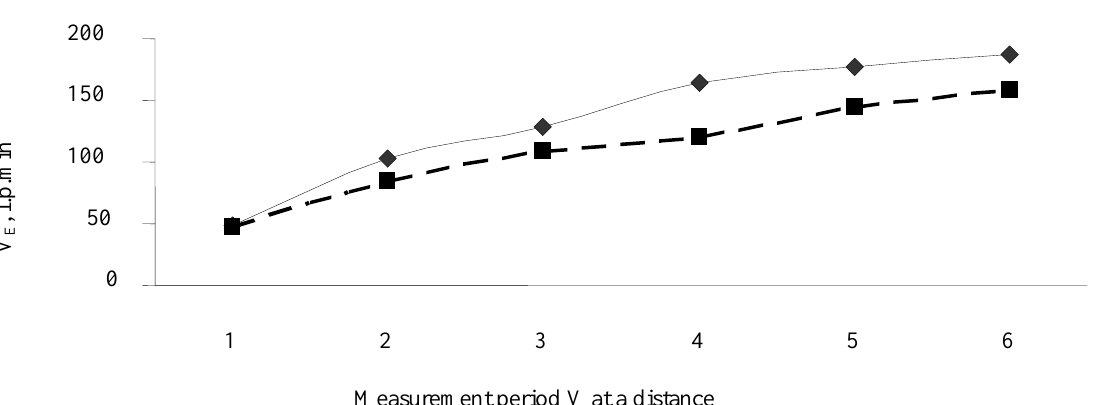
Fig.1. Dynamic of lung ventilation’s response in process of 1 min. Test with work of maximal intensity (average indicators of three rowers, who had the highest (continuous line) and the lowest (dotted line) indicators of